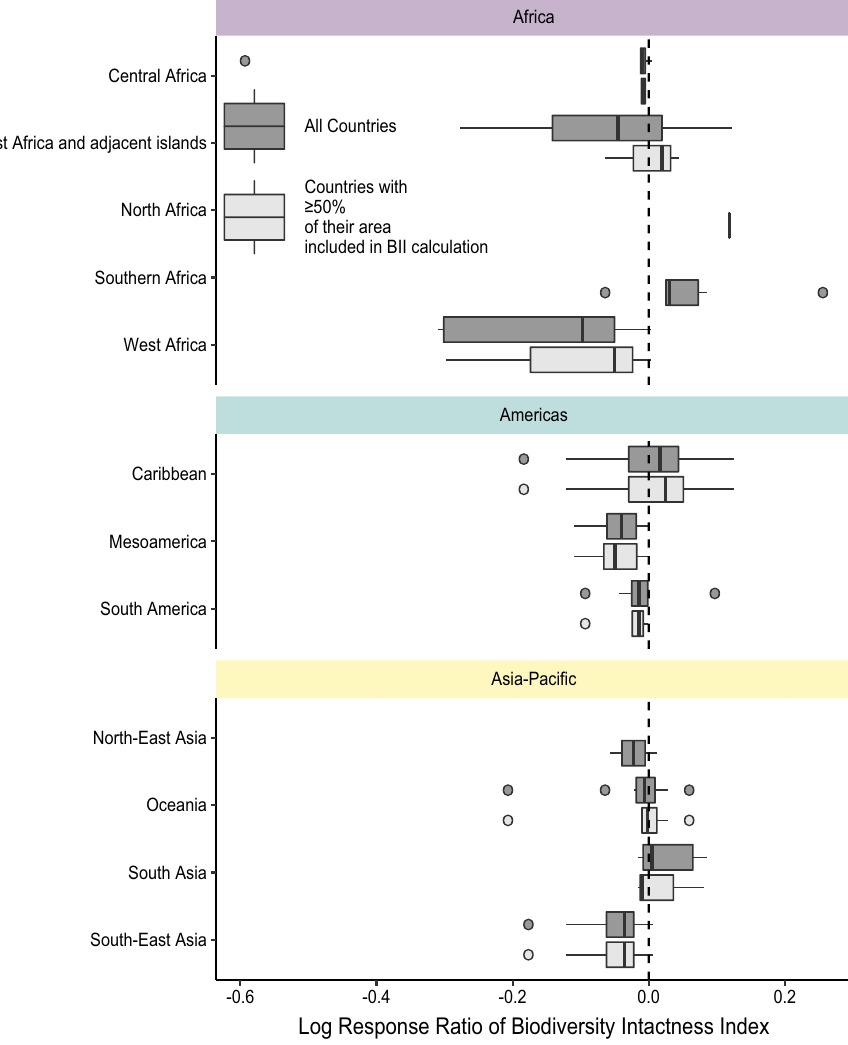
Figure 2. Average change in BII over time at the country level, across different subregions. Change was calculated as the log-response ratio of 2012 and 2001 values. A value of zero indicates no change (identified by the dashed line), negative values indicate a decline over time, and positive values indicate an increase in BII over time. Darker boxes include all countries; lighter boxes use data for countries where BII has been calculated for at least 50% of their area. The center line of the boxplot indicates the median value, boxes show data within the 25th–75th percentiles, whiskers show points that are up to 1.5 × the interquartile range of the data, points are data that fall outside of these limits. Outliers are shown as